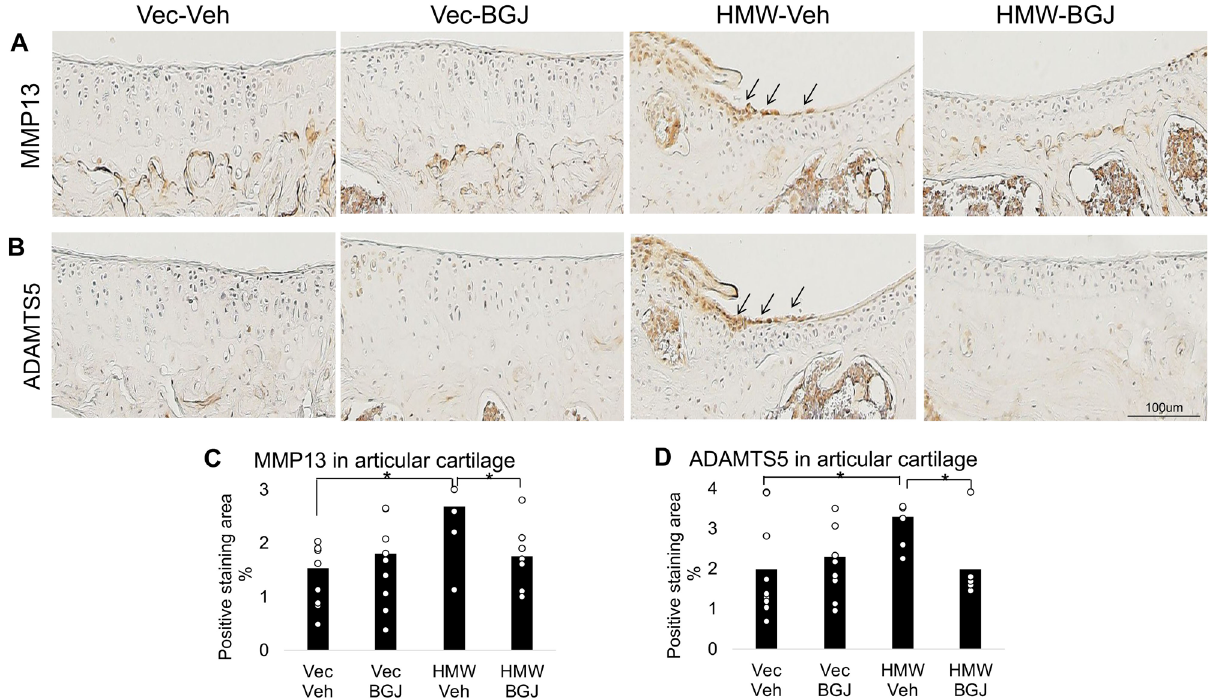
Figure 4. Expression of matrix degrading enzymes in knee articular cartilage of 9.5-month-old Vector-Control and HMWTgFGF2 mice treated with BGJ398. Eight-month-old Vector-Control (Vec) and HMWTgFGF2 (HMW) female mice were sq injected with vehicle or BGJ398 5 days/week for 6 weeks. At the end of the experiment (9.5-month- old), knee joints were collected for IHC staining. Representative immunohistochemical staining images for ( A ) MMP13 and ( B ) ADAMTS5. Quantitative analysis of percent-positive staining area for ( C ) MMP13 and ( D ) ADAMTS5 in articular cartilage. MMP13 and ADAMTS5 expression were increased in knees of HMWTgFGF2 vehicle-treated mice compared with Vector-Control vehicle-treated mice; these were rescued by BGJ398 treatment. Data are shown as mean and individual points. n = 7–9 mice/group. *p < 0.05 by two-way